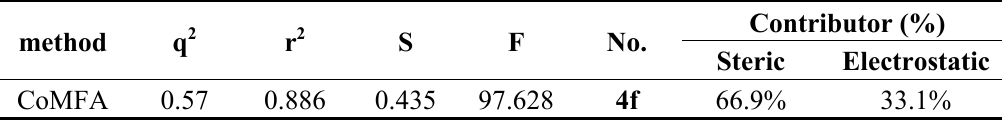
Table 4. Summary of CoMFA analysis.